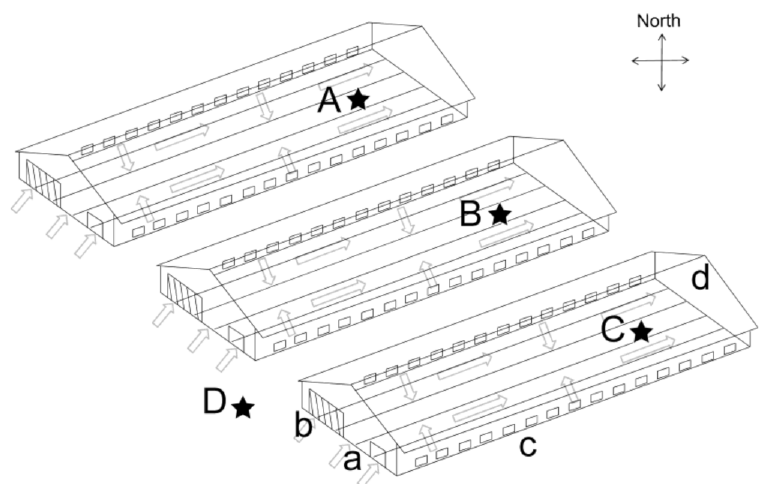
Figure 1. Schematic diagram of the broiler houses’ internal structures. The arrows represent directions of air flow. The sampling positions were at the same height as the middle-layer cages, located at A, B, C, and D (outside of cooling pad). a, entrance; b, evaporative cooling pad; c, variable side inlets; d, exhaust